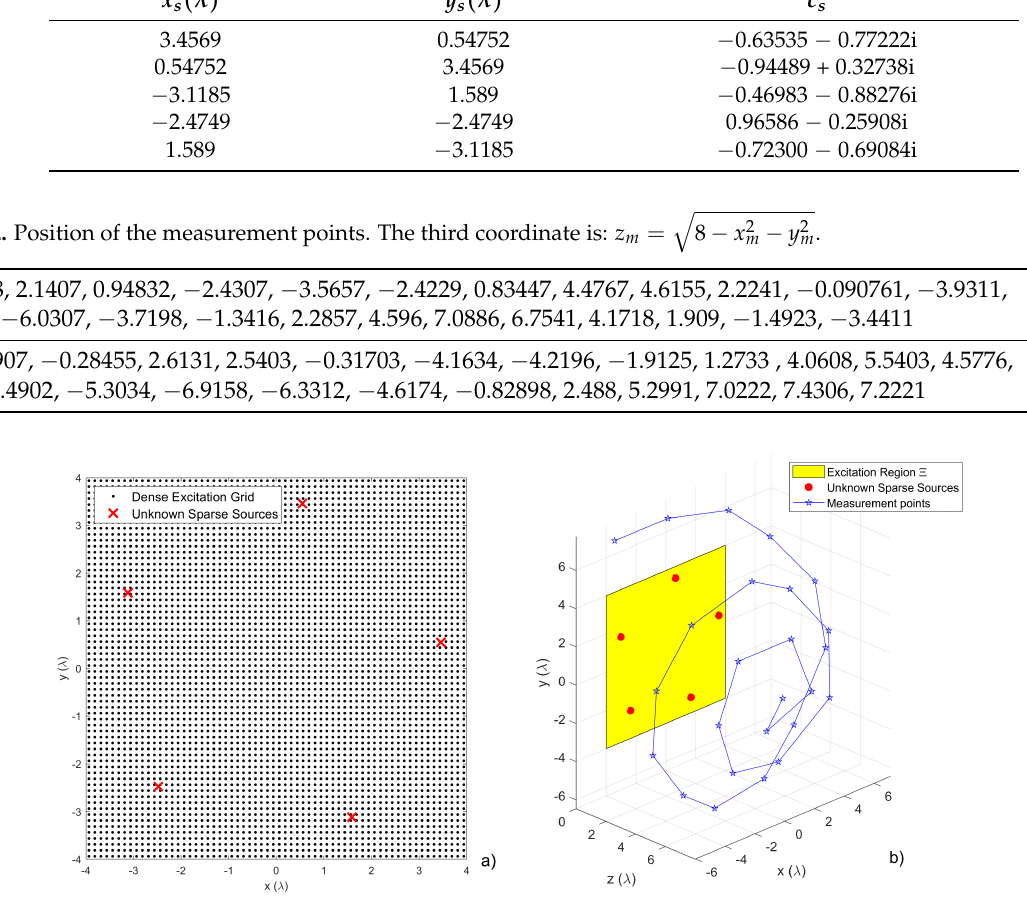
Figure 3. Sketch of the system. Subplot ( a ): the dense grid and the position of the unknown excitation; subplot ( b ): Perspective view, with the position of the measurement